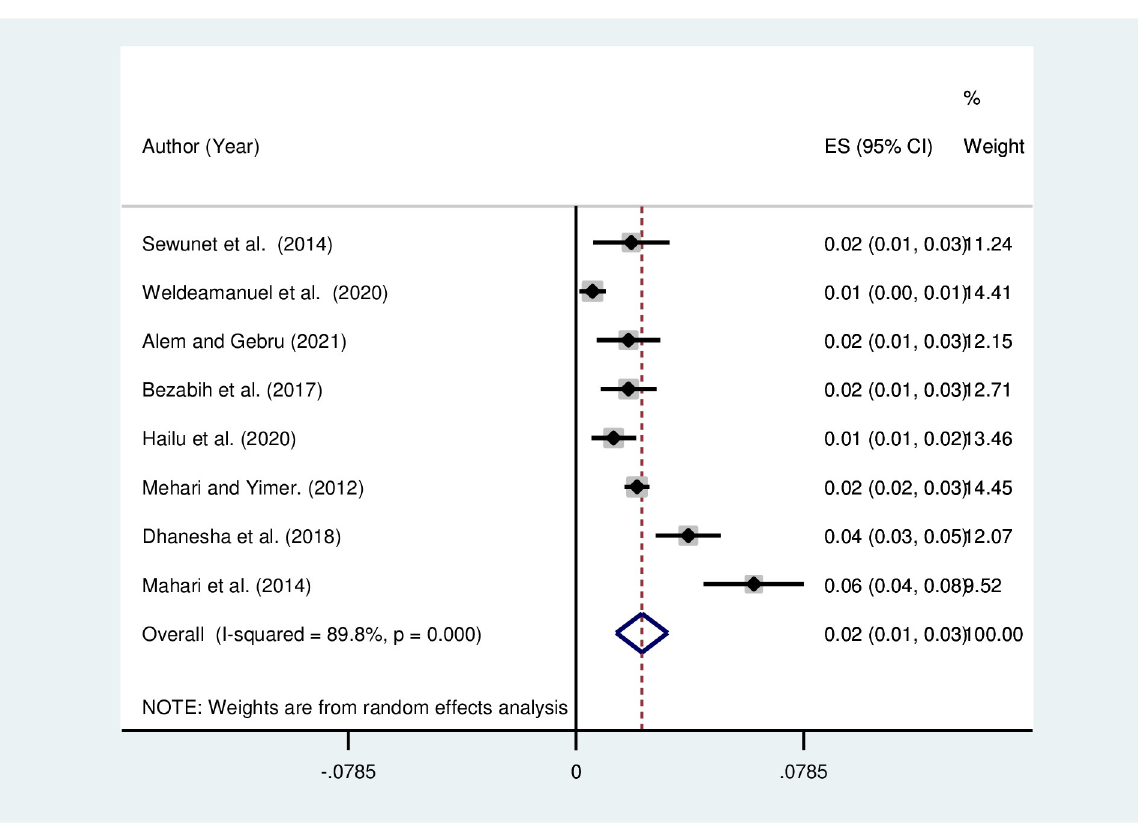
Fig 6. Funnel plot showing the pooled prevalence of visual impairment due to astigmatism in Ethiopia, 2021.